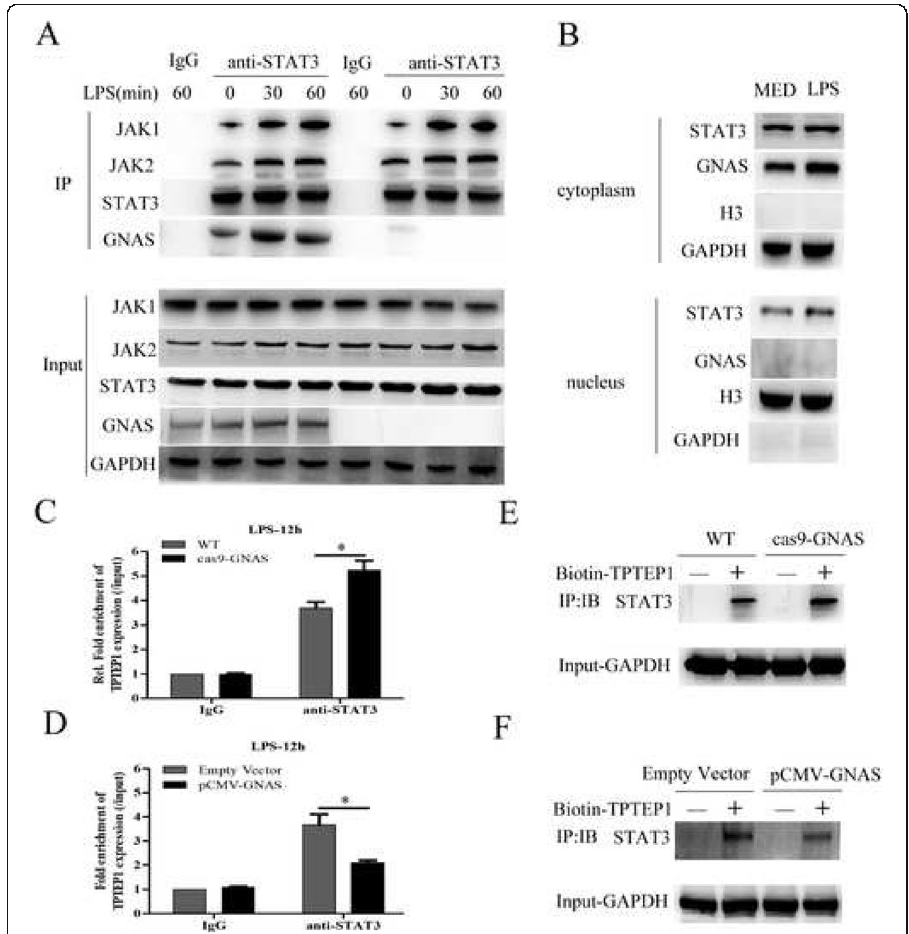
Fig. 6 GNAS promotes LPS-induced STAT3 activation in HCC cells through inhibiting long non-coding RNA TPTEP1 interacting with STAT3. a HepG2 cells or GNAS knockout-HepG2 cells were treated with LPS (5 μ g/ ml) or not for the indicated hours. Then, the interactions of JAK1/2, STAT3 and GNAS were detected by CO- IP. b HepG2 cells were treated with LPS (5 μ g/ml) or MED for 12 h, and then the protein expression levels of STAT3 and GNAS in the cytoplasmic and nuclear fractions were detected by Western blotting (GAPDH as the cytoplasmic marker, and histone H3 as the nuclear marker). c HepG2 cells or GNAS knockout-HepG2 cells were treated with LPS (5 μ g/ml) or not for 12 h. The interaction between STAT3 and TPTEP1 was detected by RIP. d HepG2 cells were transfected with pCMV-myc vector or pCMV-myc-GNAS for 24 h, and then treated with LPS (5 μ g/ml) or not for 12 h. The interaction between STAT3 and TPTEP1 was detected by RIP. e The interaction between biotin-labeled TPTEP1 and STAT3 in HepG2 cells or GNAS knockout HepG2 cells was detected by RNA pull-down. f The interaction between biotin-labeled TPTEP1 and STAT3 in HepG2 cells or GNAS overexpressed-HepG2 cells was detected by RNA pull-down. Data are represented as means ± SD ( n = 3; * represents P <